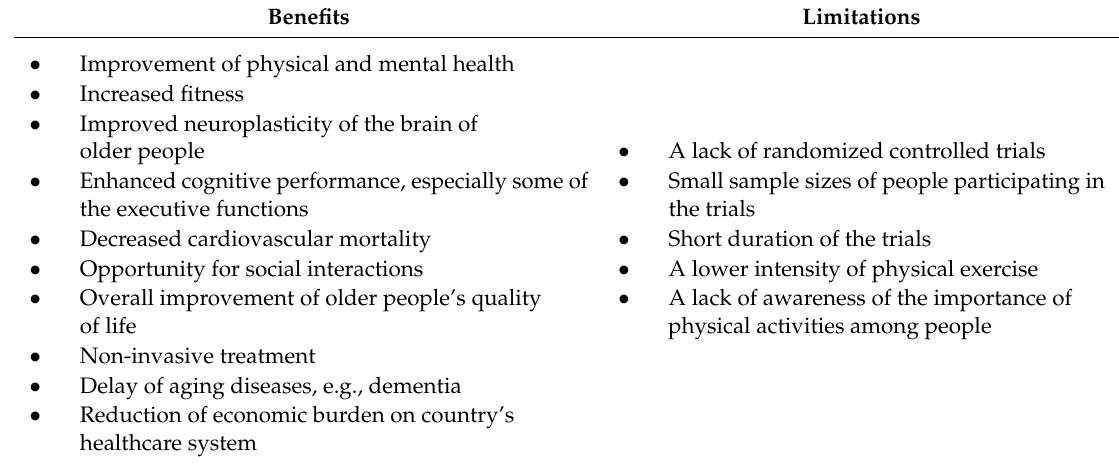
Table 2. Overview of the key benefits and limitations of physical activities for healthy older individuals (authors’ own